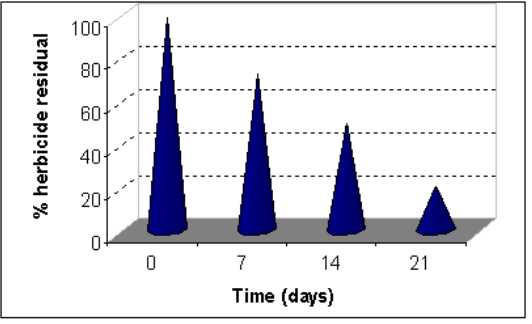
FIGURE 3 . Biodegradation in PCB of chlorsulfuron (500 mg/l) by A. niger strain.